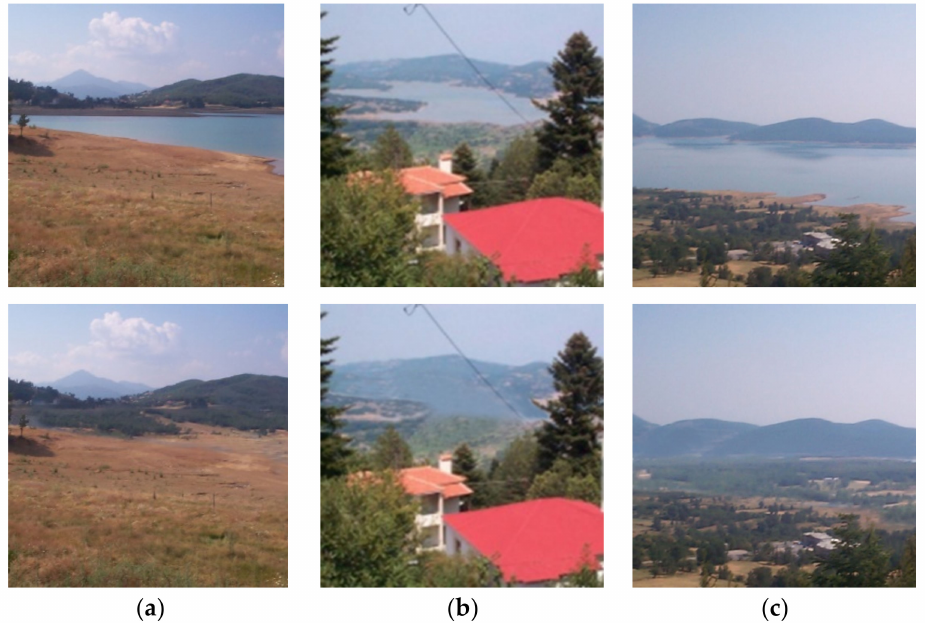
Figure 8. Plastiras reservoir north part; Viewpoints of Figure 6 ( a ) N.a; ( b ) N.b; ( c ) N.c; First row, original view; Second row, transformed images without lake.